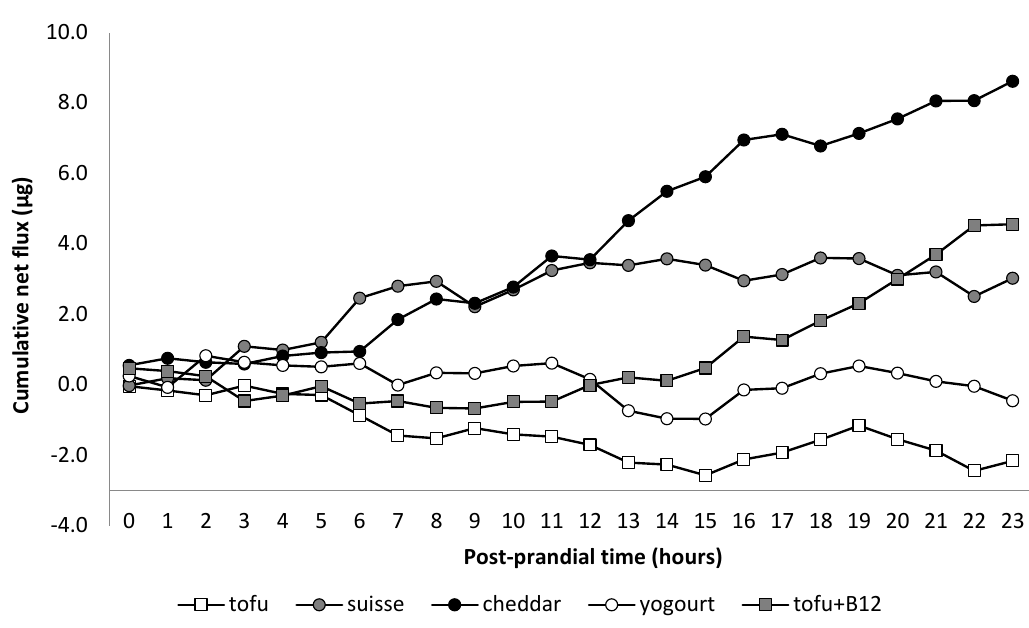
Figure 1. Calculated cumulative net portal-drained viscera flux of B 12 (µg) by post-prandial time. TF = tofu; SC = Swiss cheese; CC = Cheddar cheese; YG = yogurt; TB 12 = tofu + vitamin B 12 .